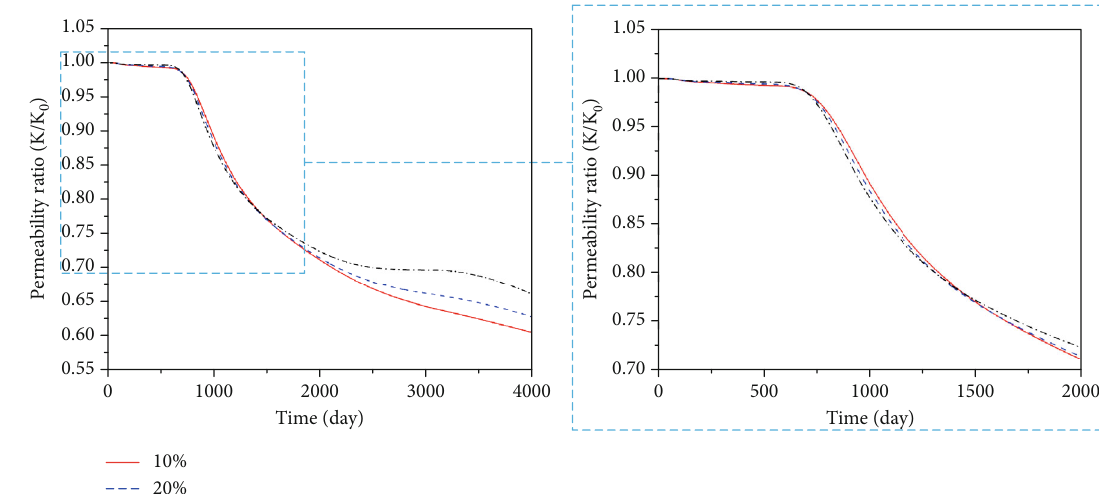
Figure 22: Evolution of permeability ratio at the reference point (P2).